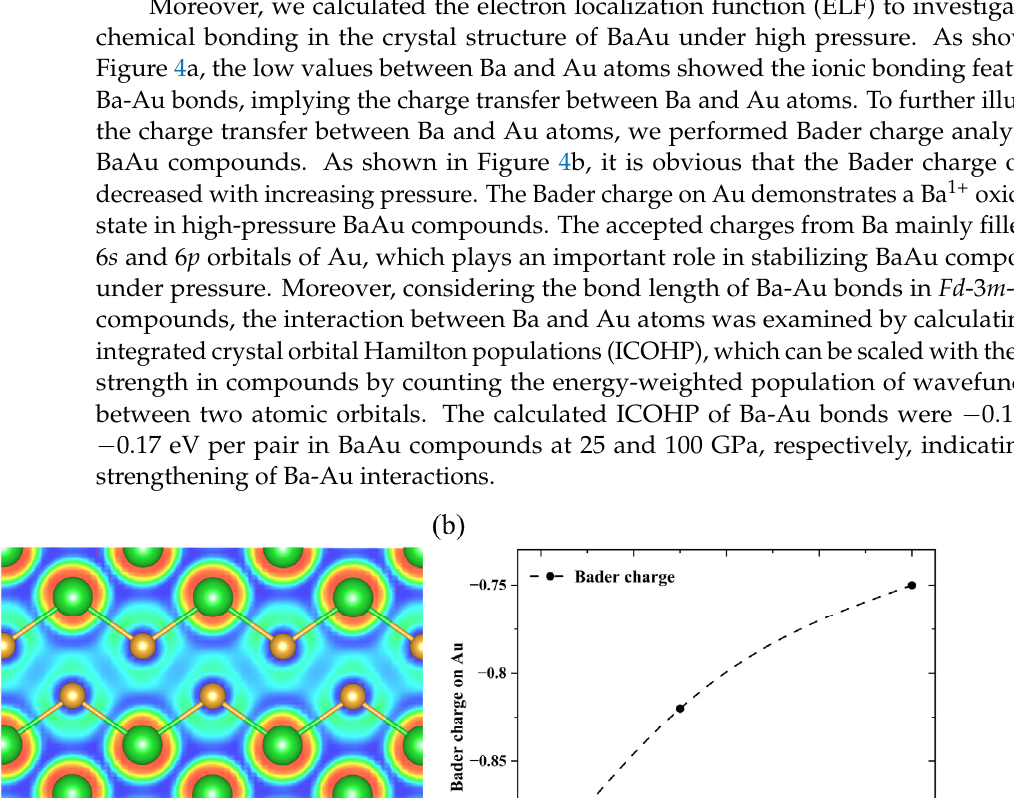
Figure 5. PDOS calculated for CsAu ( a ) and BaAu ( b ) with the CsCl-type structure at 0 GPa. 4. Conclusions